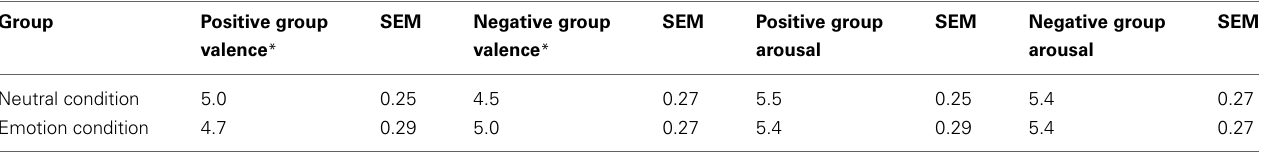
Table 1 | SAM Scores for both groups in both affect